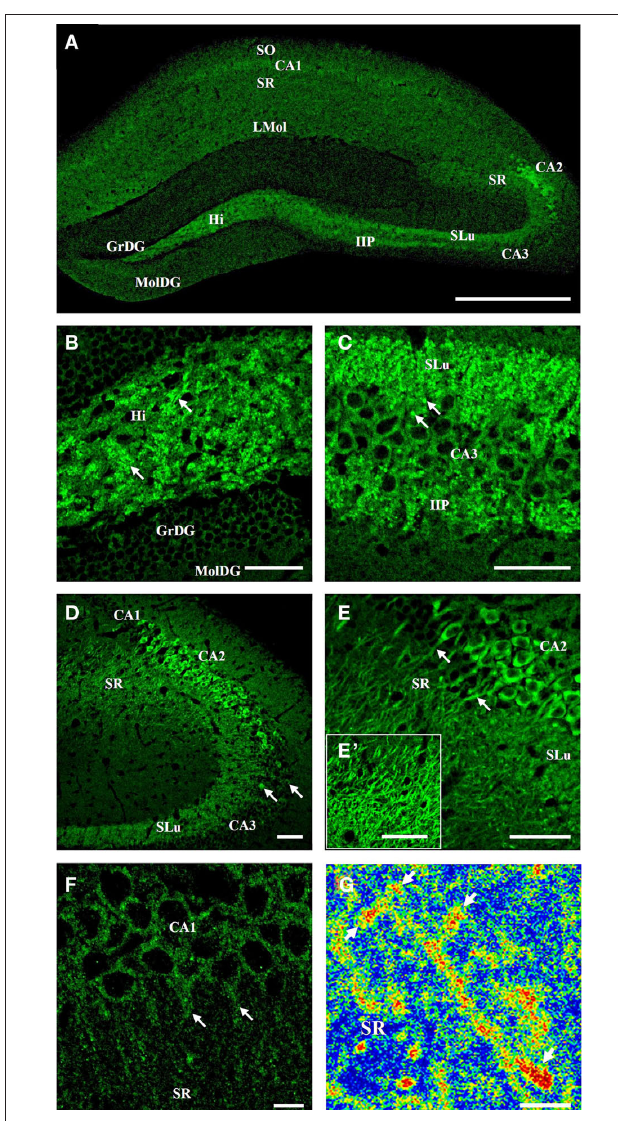
Figure 2 | Tomosyn expression pattern in the mouse hippocampus. Immunofluorescence staining of coronal slices of mouse hippocampus. (A) General expression of tomosyn in the hippocampus: high levels can be seen in the hilus, mossy fibers, CA2 and CA1 pyramidal cells. (B) Hilus: high levels in a punctate pattern in the hilus (arrows). (C) Mossy fibers: high levels in the stratum lucidum and intra- and infrapyramidal of the mossy fibers, with mossy fiber terminals labeling (arrows). (D) CA3: low cytoplasmic levels in the CA3 pyramidal cells, with a few strongly labeled cells (arrows). (e) CA2: very high cytoplasmic levels in the CA2 pyramidal cells, with dendrites labeling in the stratum radiatum of CA2 (arrows). (e ′ ) Stratum radiatum of CA2: high levels of tomosyn in dendrites. (F) CA1: low cytoplasmic levels in the CA1 pyramidal cells, with dendrites labeling in the stratum radiatum of CA1 (arrows). (g) High-resolution image taken with two-photon microscopy from the dendrites of CA2 pyramidal cells in the stratum radiatum of CA2 of tomosyn1-knockout mouse. Rainbow mode shows high levels (in red color) of tomosyn2 in spine-like structures along the dendrite (arrows). SO, stratum oriens; SR, stratum radiatum; LMol, stratum lacunosum-moleculare; SLu, stratum lucidum; IIP, intra- and infrapyramidal; Hi, hilus; GrDG, granular layer of dentate gyrus; MolDG, molecular layer of dentate gyrus. Scale bar: (A) = 500 μm, (B–e ′ ) = 50 μm, (F) = 10 μm, (g) = 5